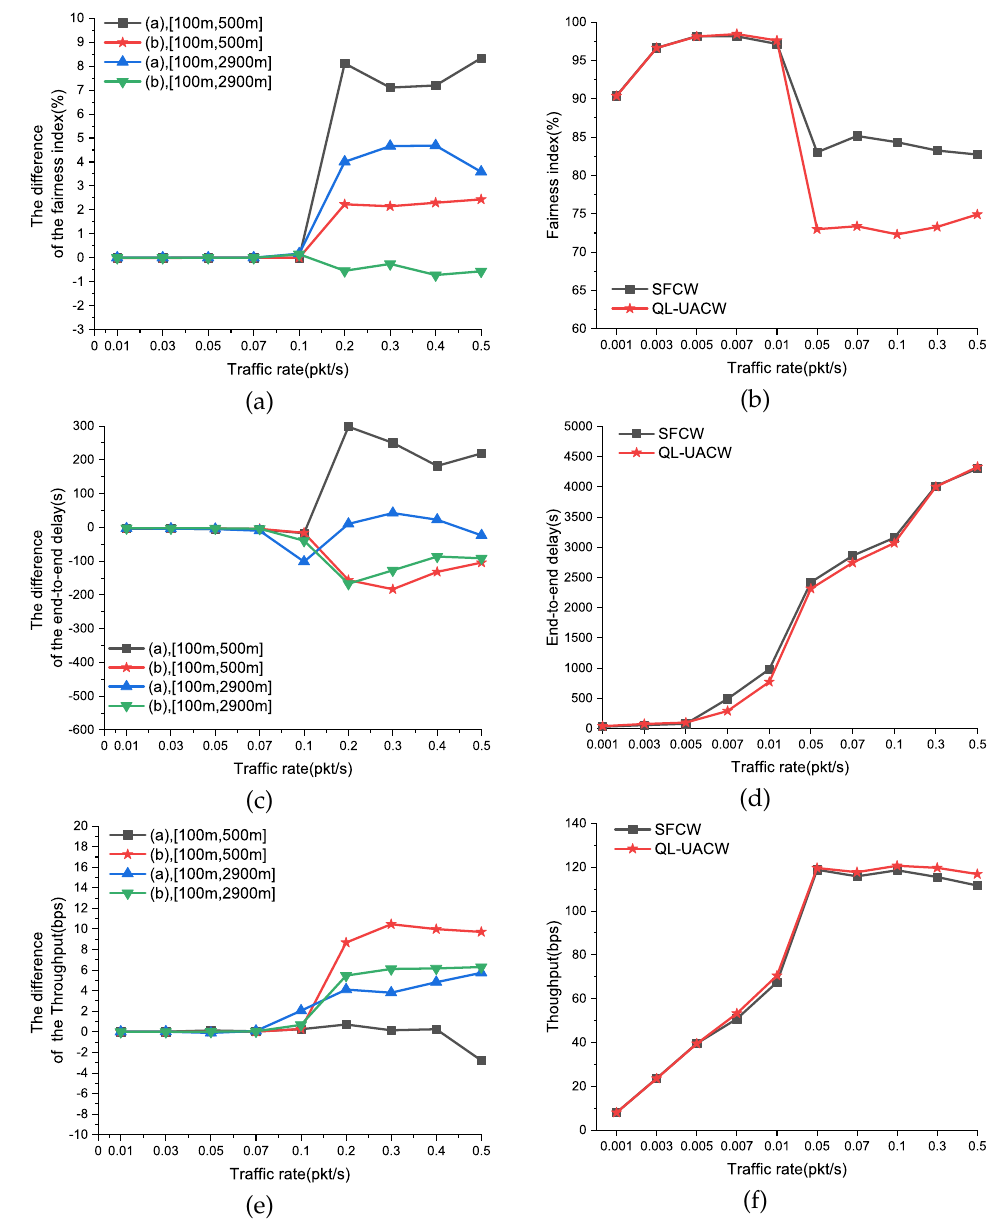
Figure 11. The performance of SFLC–MAC and QL–UACW in relation to the traffic rate. ( a ) The difference of the fairness index in 4–Node topology. ( b ) The fairness index in 16–Node topology. ( c ) The difference of the end–to–end delay in 4–Node topology. ( d ) The end–to–end delay in 16–Node topology. ( e ) The difference of the throughput in 4–Node topology. ( f ) The thoughput in 16–Node